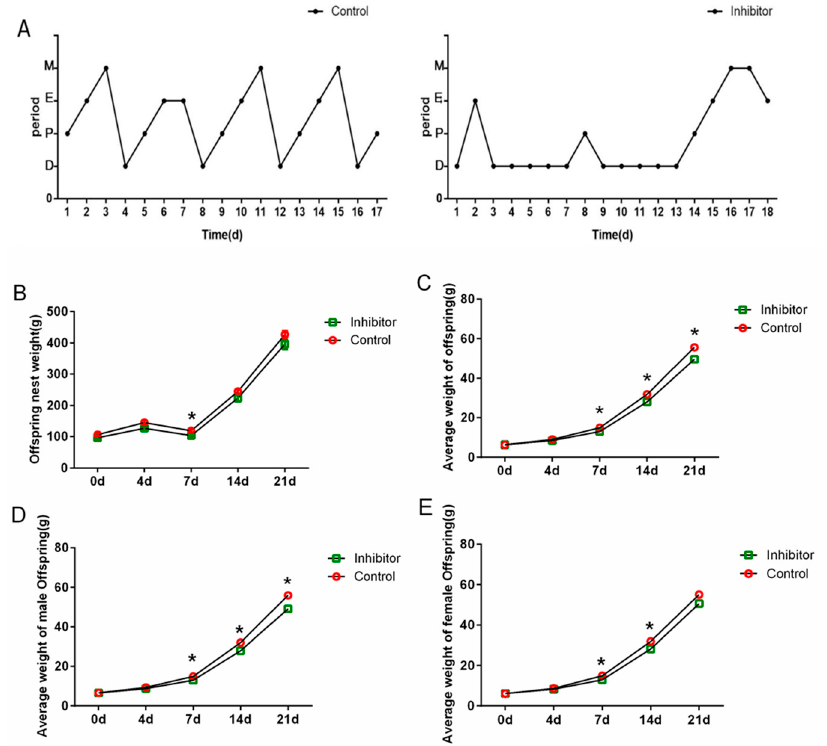
Figure 4. Effects of GABA-T inhibitor treatment on estrous cycle and offspring weight in adult female rats. M:metaoestrus, E:estrus, P:preoestrus, D:diestrus. ( A ) Changes in estrus cycle in adult female rats. The estrous cycle of the control group was normal, but the estrous cycle of the inhibitor group was disordered. ( B ) Offspring nest weight. ( C ) Offspring average weight. ( D ) Male offspring average weight. ( E ) Female offspring average weight. Adult rat age is 64.46 ± 0.46 d. Vigabatrin was used as a GABA-T inhibitor.